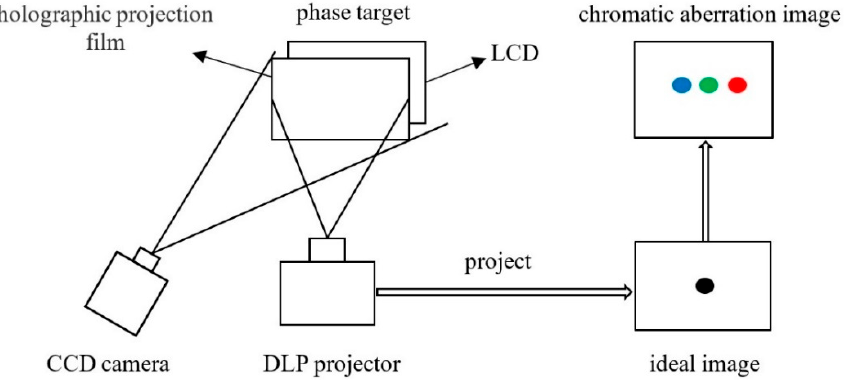
Figure 2. Schematic diagram of radial chromatic aberration measurement. (DLP: digital light programming; CCD: charge coupled device; LCD: liquid crystal display).